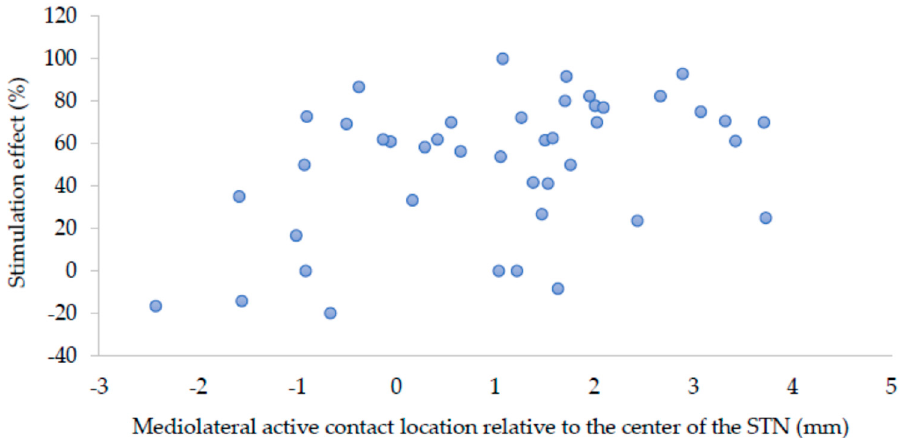
Figure 2. Distribution of the active contact locations after one year in a ventral, anterior, and lateral view. The gray shape represents the generalized STN, identical for all patients. Locations are color-coded corresponding to their contralateral off-medication stimulation effect. Overall, the distribution of the locations is centered on the anterior part of the dorsolateral STN. The relation with stimulation effect is most striking in the anterior view, where the locations at the lateral and ventral part of the distribution often correspond to good stimulation effect (red), while locations at the medial and dorsal part of the distribution often corresponding to poor stimulation effect (yellow). (A = anterior, D = dorsal, L = lateral, M = medial, P = posterior, and V = ventral, locations displayed on the axes are in mm).